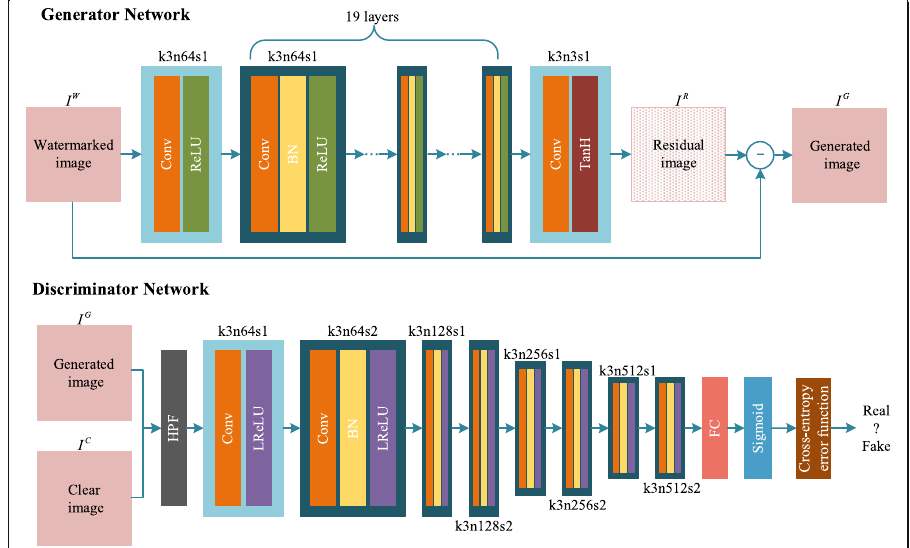
Fig. 2 Architecture of generator and discriminator network with kernel size (k), number of feature maps (n), and stride (s) represent the parameters of each convolutional